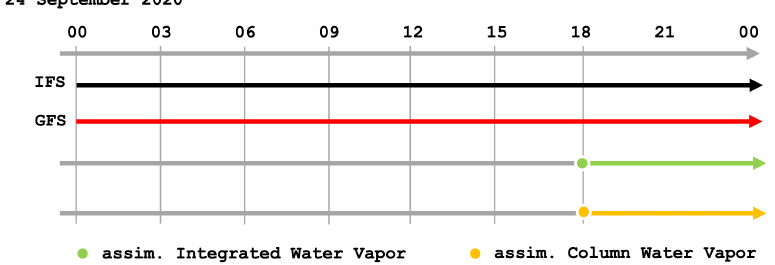
Figure A1. Scheme of the OSSE experiment for the case study of 24 September 2000. In black, the Virtual Reality (VR) initialized with ECMWF-IFS data; in red, the control run (CTRL) initialized with NCEP-GFS data; in green and yellow, two ASSIM simulations made at 18 UTC with the same forecast, but forced with the 3D-VAR assimilation of precipitable water and WV vertical profile data,